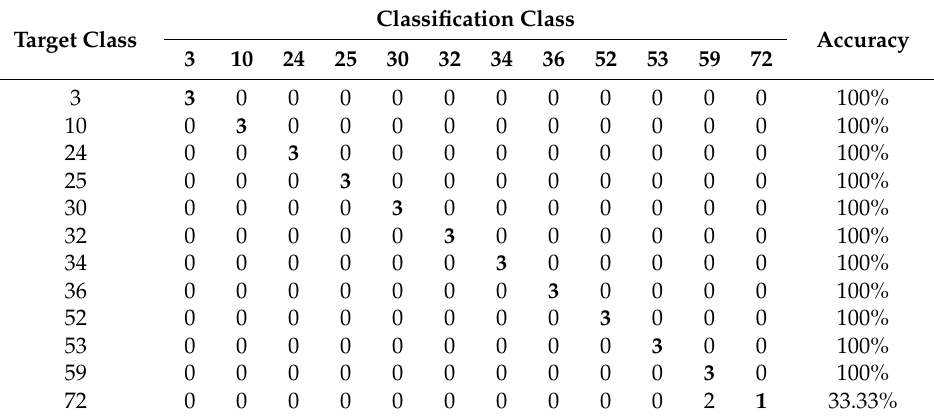
Table 7. Confusion matrix for true identification of